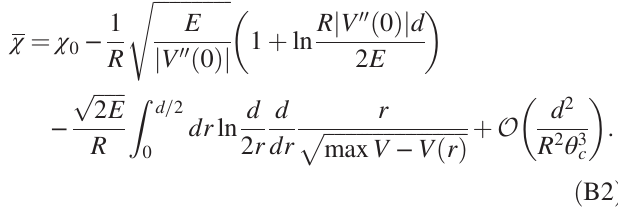
r − d ffiffiffiffiffiffiffiffiffiffiffiffiffiffiffiffiffiffiffiffiffiffiffiffiffiffiffi